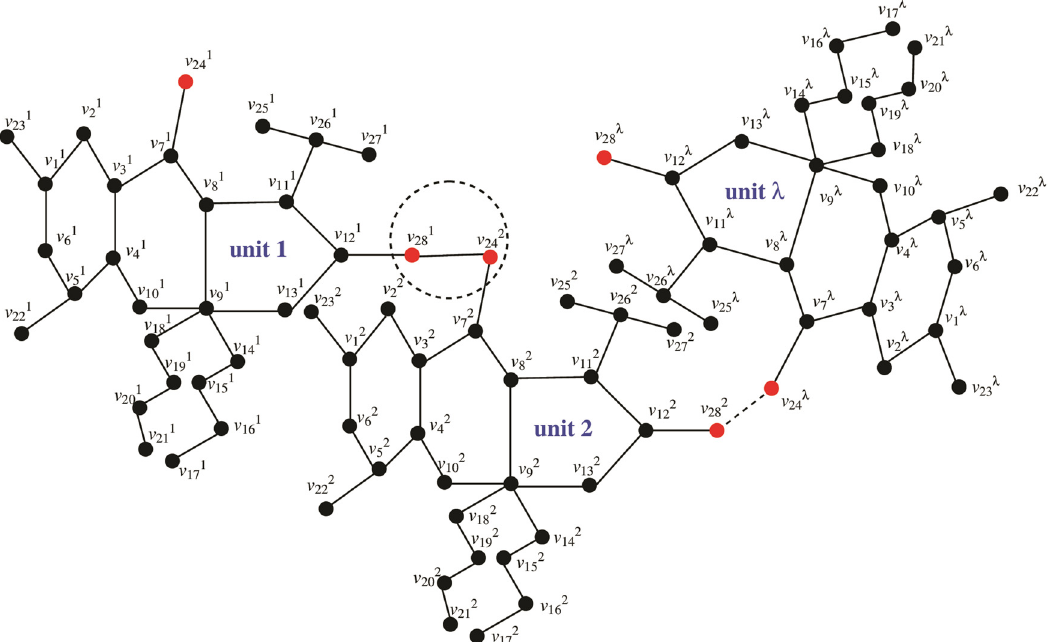
Figure 3: Supramolecular chain of complex -